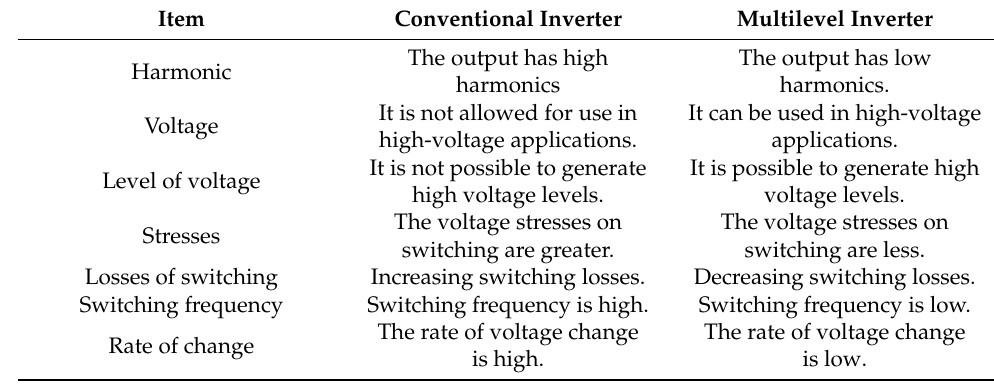
Table 2. Comparison between multilevel and traditional